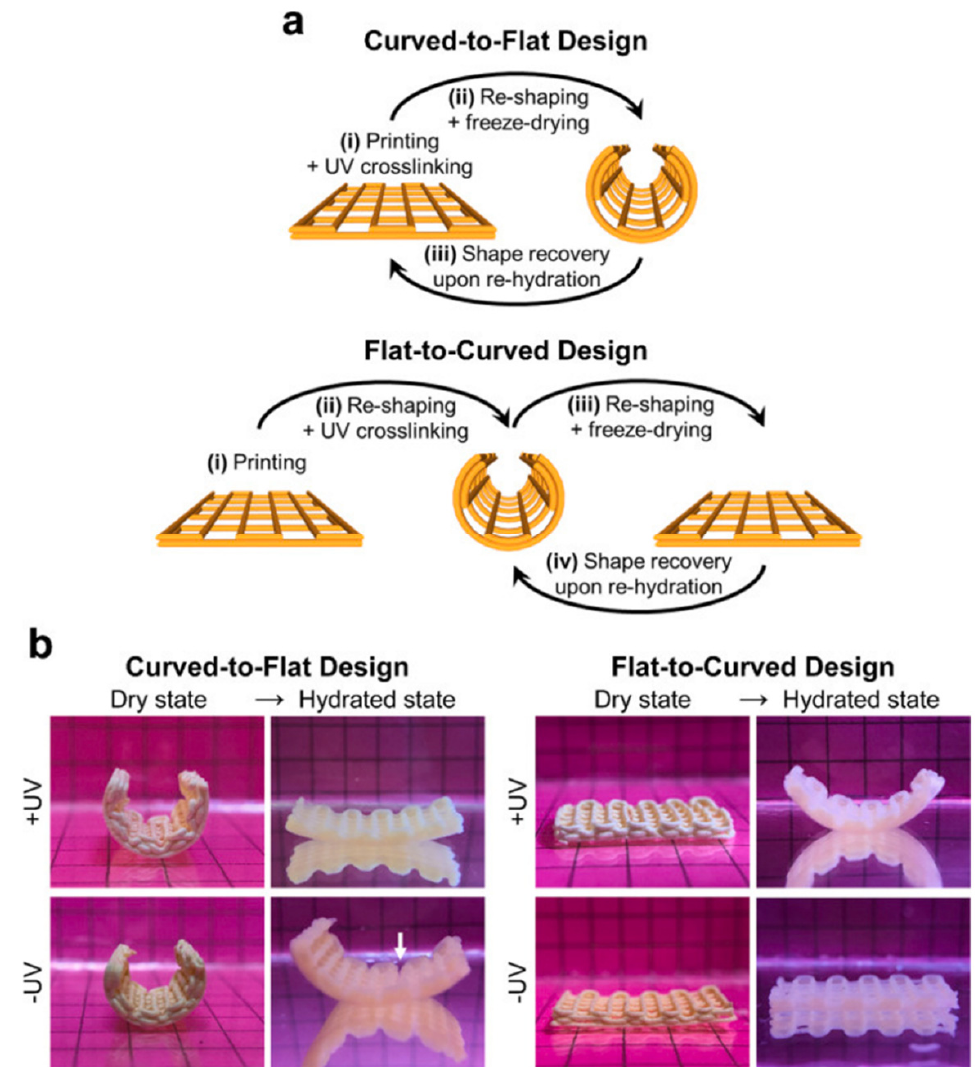
Figure 1. Four-dimensional bioscaffolds with water (humidity) responsiveness by DIW printing technology. Shape memory behavior of printed constructs. ( a ) Schematic illustration of fabrication steps of constructs with shape memory capacity. ( b ) Digital photographs of different construct designs at dry state (temporary geometry) and in the hydrated state showing their shape recovery performance upon immersion in aqueous media. Such deformation characteristics create conditions for minimally invasive implantation of bone grafts. (Reproduced with permission [75]. Copyright 2021,